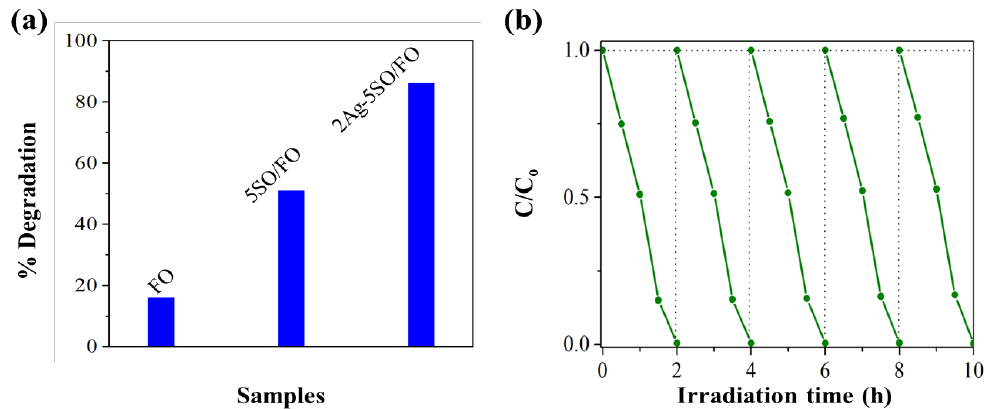
Figure 1. Photocatalytic aerobic degradation for 2,4-DCP over ( a ) FO, 5SO/FO, and 2Ag-5SO/FO, respectively; ( b ) recycle test of 2Ag-5SO/FO for photocatalytic 2,4-DCP degradation.